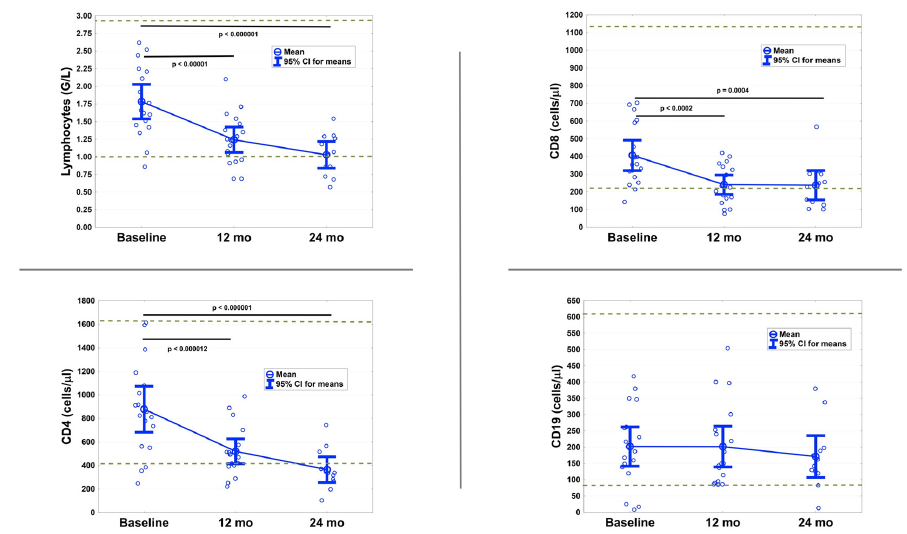
Figure 2. Lymphocyte subset analysis showing the impact of cladribine (CLAD) on circulating lymphocytes, cytotoxic T cells (CD8+), T helper cells (CD4+) and B cells (CD19+) before CLAD administration and at the end of each treatment year. CLAD tablets were administered at baseline and at months 1, 12 and 13 according to manufacturer’s recommendations. Dotted lines represent the normal